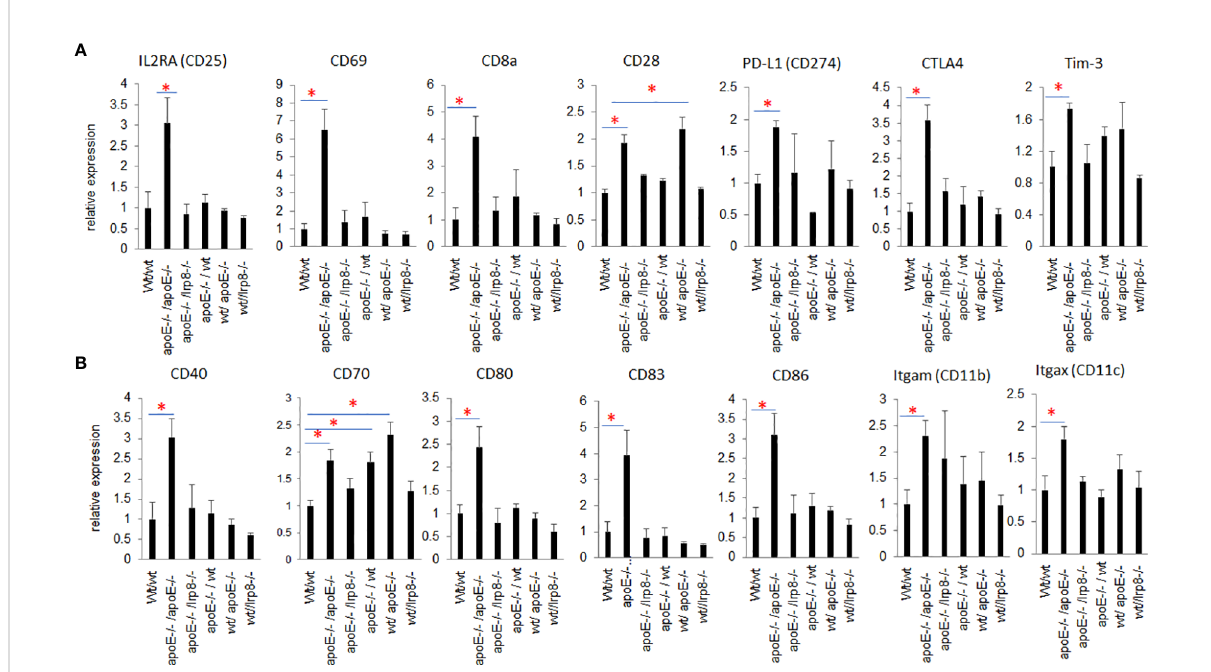
FIGURE 8 Nanostring PanCancer Immune Pro fi ling analysis of RNAseq of activation markers for T cells and DCs that in fi ltrated into the tumors from the 6 different groups. (A) Activated T cell genes and (B) activated DC genes were all statistically signi fi cantly increased in the tumor from apoE-/-/ apoE-/- group when compared with wt/wt control groups. The relative gene expression level was indicated on the y-axis and tumor groups are listed along the x-axis. Results are expressed as mean score ±SE. *p<0.05, determined by unpaired two-tailed Student ’ s